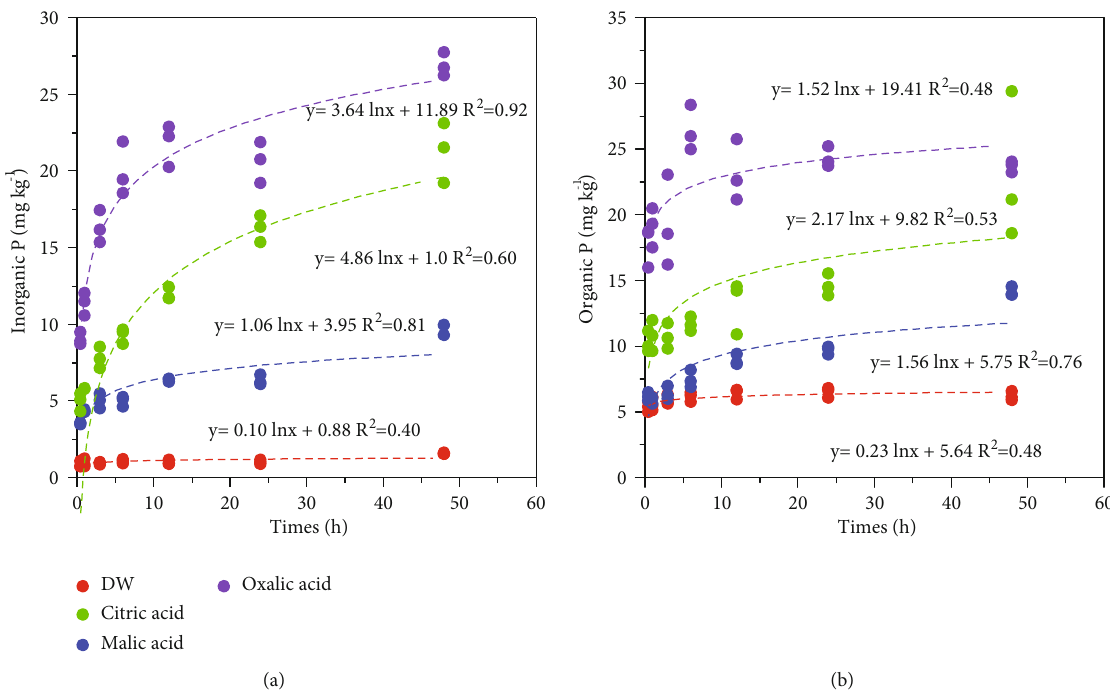
Figure 3: The kinetics of inorganic P (Pi, a) and organic P (Po, b) release by water, oxalic acid, citric acid, and malic acid at 100 mmolkg -1 soil from the acidic forest soils. DW: deionized water.